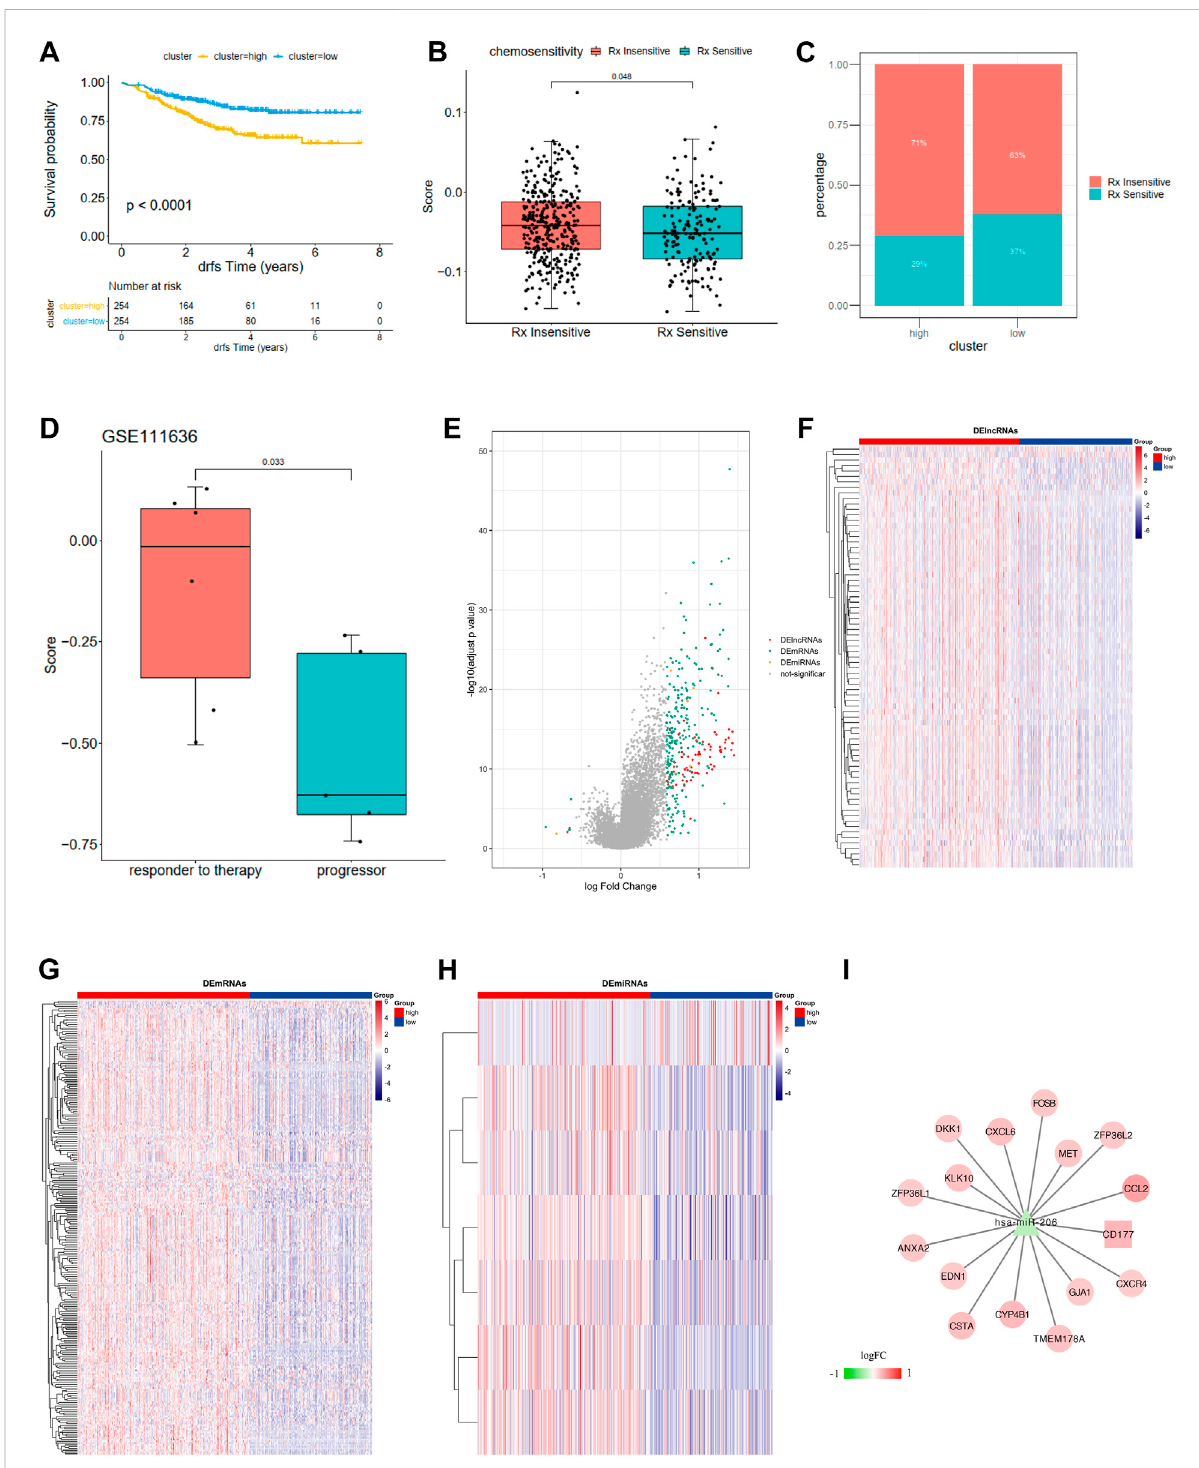
FIGURE 7 (A) Kaplan-Meier curves show overall survival in the WM_Score-high (yellow) and -low (blue) subgroups after the immunotherapy in the GSE25066. The grouping of patients is shown at the bottom of the chart. P < 0.05 in the two-sided log-rank test was considered statistically signi fi cant. (B) The proportion of patients in the GSE25066 with different responses to chemotherapy. The fi sher test was used to determine the statistical signi fi cance of the difference. (C) The difference betweendistinct between the WM_Score high and low groups in the GSE25066. (D) The difference in the WM_Score between distinct clinical outcomes of anti-PD-1 treatment in the GSE111636. (E – I) WM_Score -High and -low differential expression of miRNA, lncRNA, mRNA (E: differential volcano map; FGH: differential lncRNA, mRNA, miRNA heat map, respectively) and ceRNA network (I: square is lncRNA, triangle is miRNA, circles are